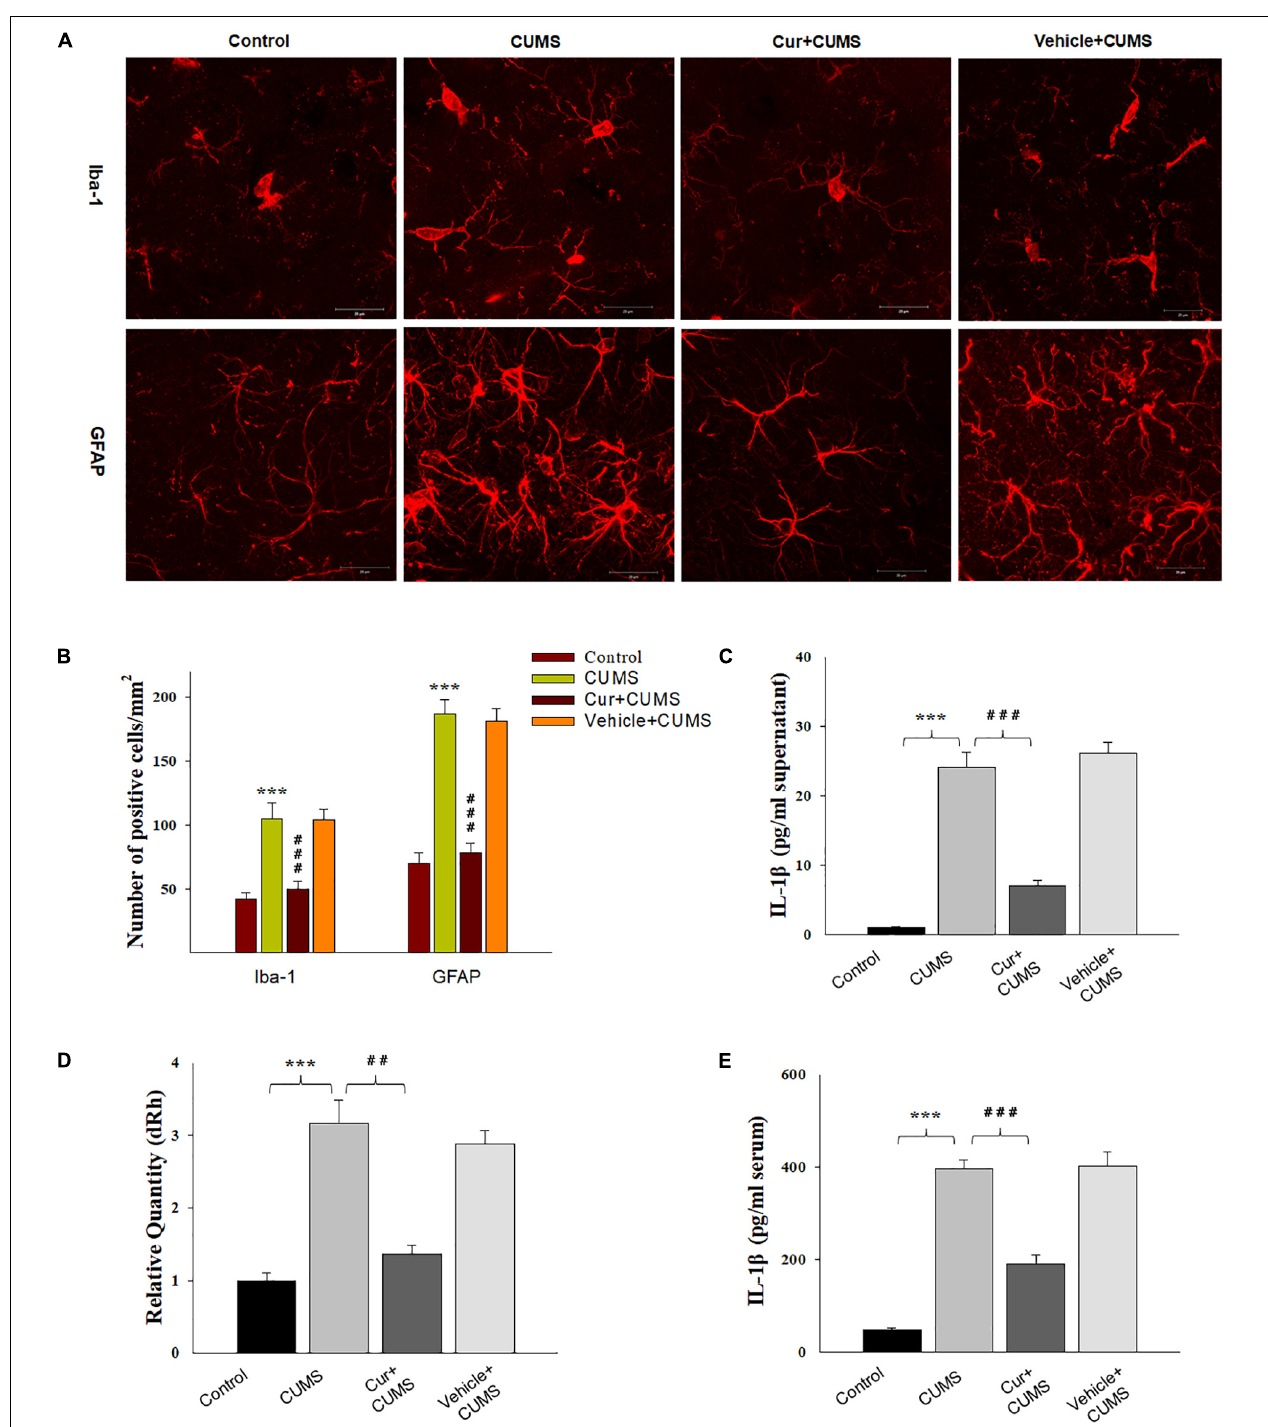
FIGURE 2 | Curcumin attenuated glial activation and IL-1 β expression induced by CUMS-exposure. (A) CUMS exposure significantly increased the number of Iba1 positive microglial cells (top) and GFAP positive cells (bottom) within the vmPFC. (B) Histograms showing the glia activation were significantly attenuated by curcumin pretreatment. (C) ELISA assays showed that CUMS exposure increased IL-1 β protein expression within the vmPFC, effects which were ameliorated by curcumin. (D) Real-time quantitative PCR assays showed that CUMS exposure increased IL-1 β mRNA expression within the vmPFC, effects which were ameliorated by curcumin. (E) ELISA assays showed that CUMS exposure increased serum IL-1 β expression, effects which were ameliorated by curcumin. Data were presented as the means ± SEM ( N = 6/group). ∗ P < 0.05, ∗∗ P < 0.01, ∗∗∗ P < 0.001 CUMS vs. Control group; # P < 0.05, ## P < 0.01, ### P < 0.001 Cur + CUMS vs. CUMS group (Cur,